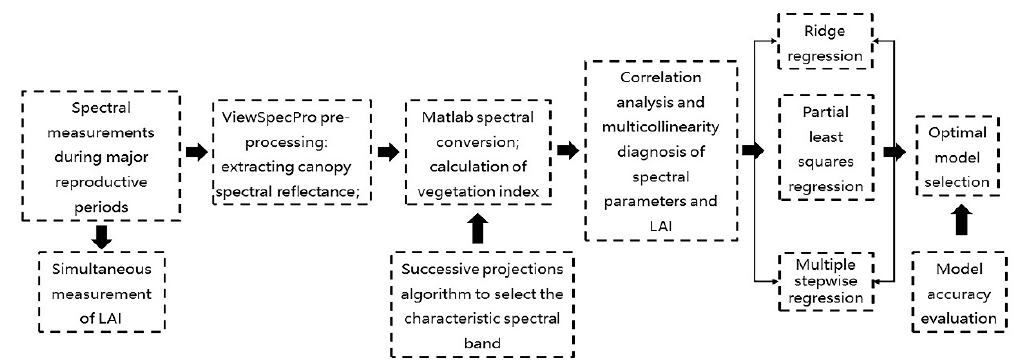
Figure 1. A flowchart of the research process.